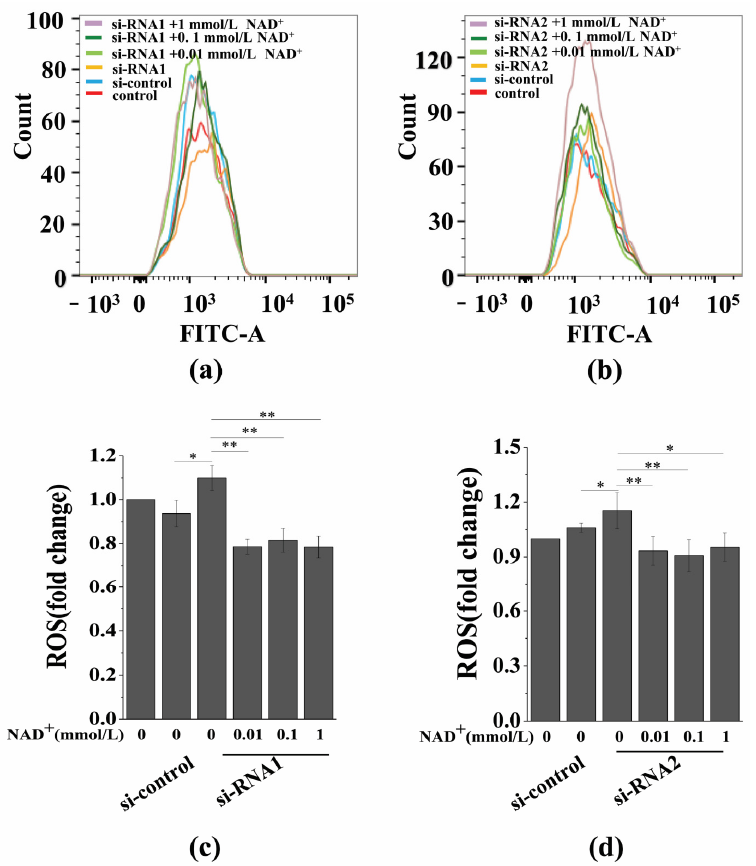
Figure 7. Sirt1 knockdown represses exogenous NAD + -inhibited intracellular ROS generation. ( a , b ) After the knockdown of Sirt1 by two different si-RNA sequences for 48 h, D-gal-induced senescent BMSCs were treated with different concentrations of NAD + for another 48 h. The detection of intracellular ROS was carried out by flow cytometry. ( c , d ) Quantitative analysis of intracellular ROS. The data are expressed as means ± standard deviation; n = 3; * p < 0.05; ** p < 0.01. BMSCs: Bone marrow-derived mesenchymal stem cells; D-gal: D-galactose; NAD + : Nicotinamide adenine dinucleotide; ROS: Reactive oxygen